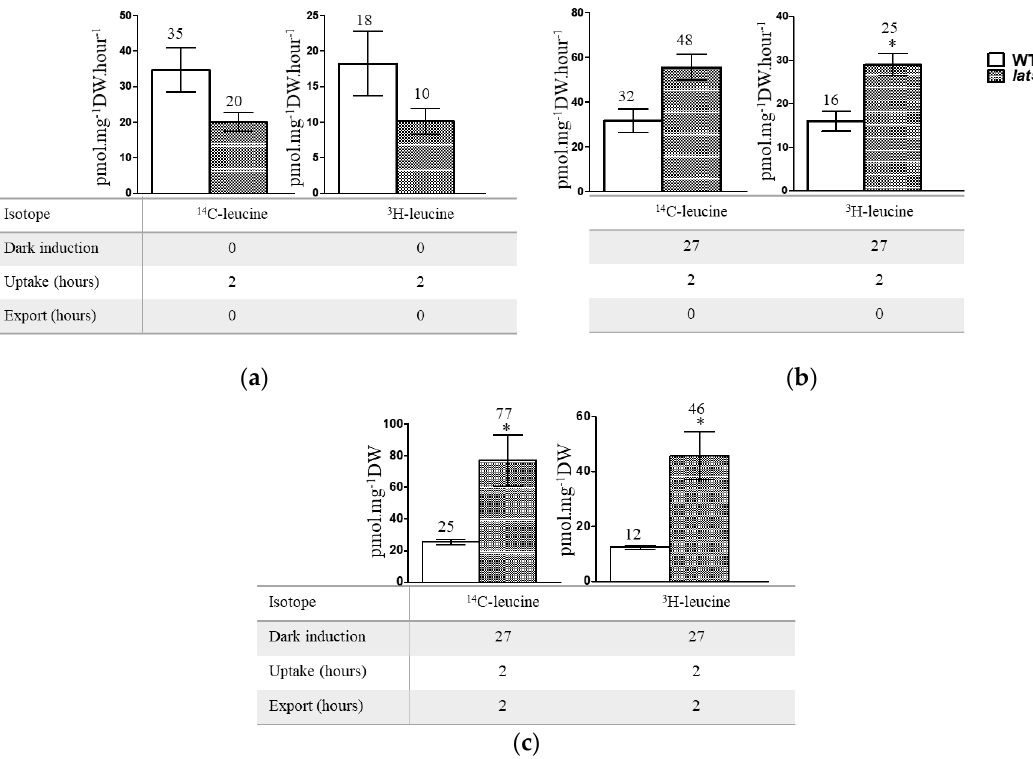
Figure 4. Radio-labelled leucine uptake study shows significantly increased accumulation of leucine in lat5-1 compared to the WT when seedlings were treated in dark prior to the isotopic feeding and allowed to export. ( a ) Seedlings grown under normal light/dark regime show decreased accumulation of 14 C- and 3 H- in the lat5-1 compared to the WT. ( b ) Seedlings, kept in dark for 27 h prior to the isotopic feeding, show increased accumulation of both 14 C- and 3 H- in the lat5-1 compared to the WT. ( c ) Seedlings, kept in dark for 27 h prior to the isotopic feeding, show significantly increased accumulation of both 14 C- and 3 H- in the lat5-1 compared to the WT when uptake was followed by export. Error bar represents standard deviation of three biological replications. * p < 0.05.